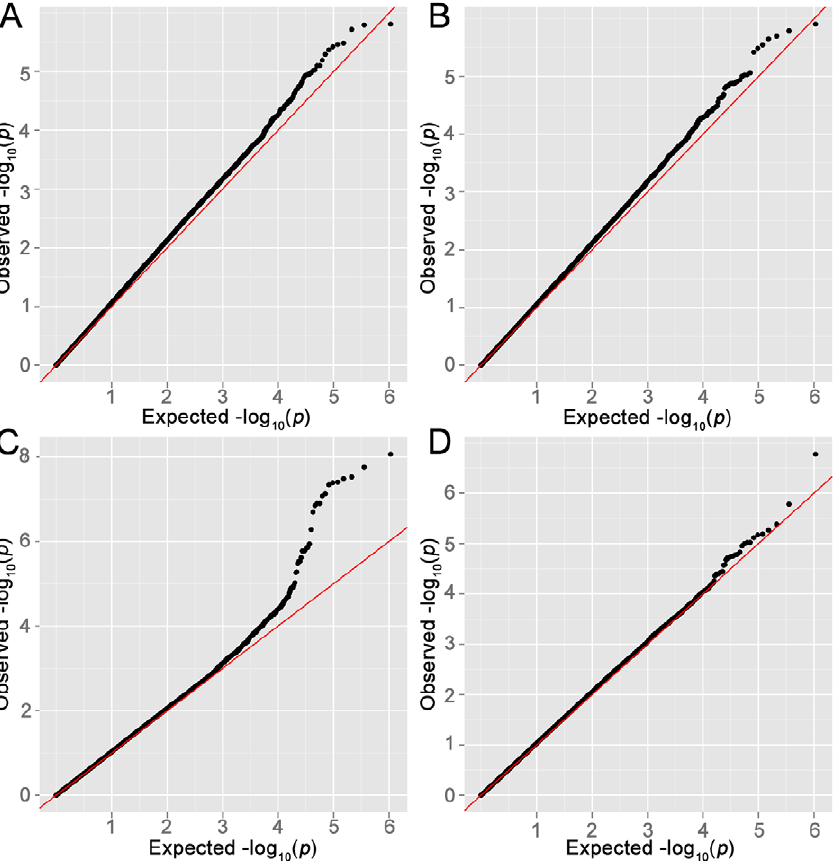
Figure 2. Quantile–quantile plots. Quantile–quantile (QQ) plots for (A) LYM, (B) NHL, (C) FL, (D) DLBCL. The X-axis represents expected 2 log 10 (P) and the Y-axis represents 2 log 10 (P) from logistic regression. Genomic inflation factor l for LYM, NHL, FL and DLBCL was 1.09, 1.07, 1.04 and 1.04 respectively.